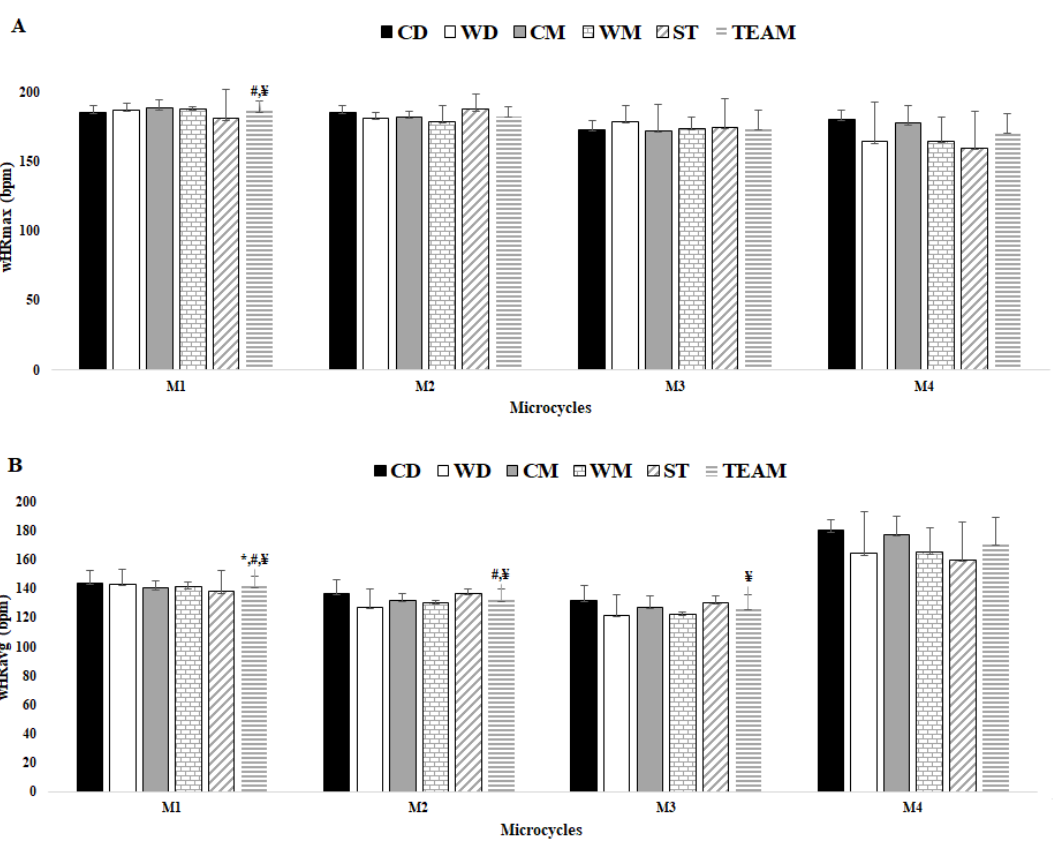
Figure 3. Comparisons between player positions for average HRmax and average HRavg for each microcycle, (e.g., M1, M2, M3, and M4) and between Ms by team average. ( A ) wHRmax; ( B ) wHRavg; * Denotes difference from M2; # denotes difference from M3; ¥ denotes difference from M4; all p < 0.05.